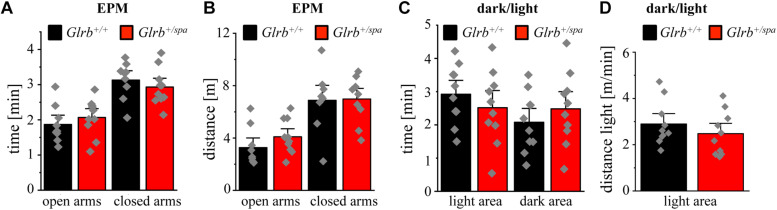
Heterozygous spastic mice prefer protected areas. (A) Time spent and (B) distance traveled in closed or open arms in the EPM for Glrb+/spa mice (n = 10, red bars) and Glrb+/+ mice (n = 9, black bars). (C) Times spent within the dark or light compartments are detected for Glrb+/spa mice (n = 10, red bars) and Glrb+/+ mice (n = 10, black bars). (D) Distance traveled for Glrb+/spa mice (n = 10, red bar) and Glrb+/+ mice (n = 10, black bar) within the light compartment divided by time spent within the light compartment is depicted as bar diagram. Data are presented as mean values ± S.E.M. Data points are shown as gray color squares.